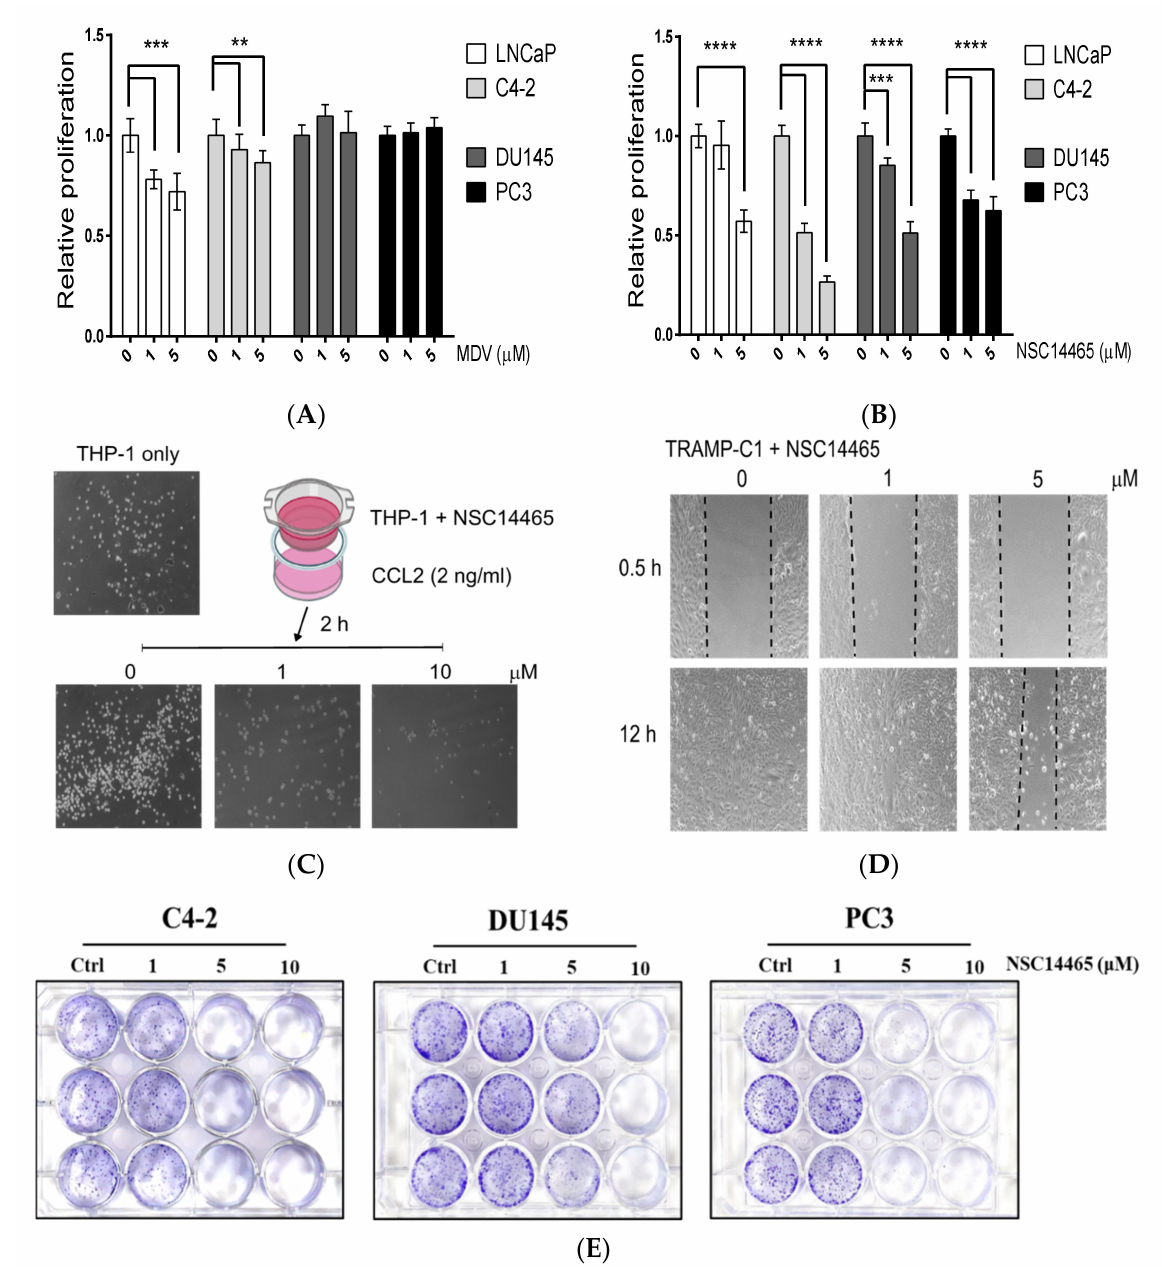
Figure 4. Anti-proliferation and anti-migration effects of NSC14465. ( A ) Monitoring proliferation of several human prostate cancer cell lines after treatment with an AR inhibitor, Enzalutamide (MDV), for 3 days. ( B ) Monitoring proliferation of several human prostate cancer cell lines after treatment with NSC14465 for 3 days. Student’s t -test: ** p < 0.01, *** p < 0.001, **** p < 0.0001. ( C ) Transwell analyses of a human monocyte cell line, THP-1, incubated with NSC14465 (0, 1, and 10 µ M) in the upper chamber and the mouse CCL2 chemokine in the lower chamber for 2 h. ( D ) Migration analyses of a mouse cell line, TRAMP-C1, following NSC14465 treatment for 12 h. ( E ) Colony assays using human prostate cancer cell lines after treatment with NSC14465 for 5